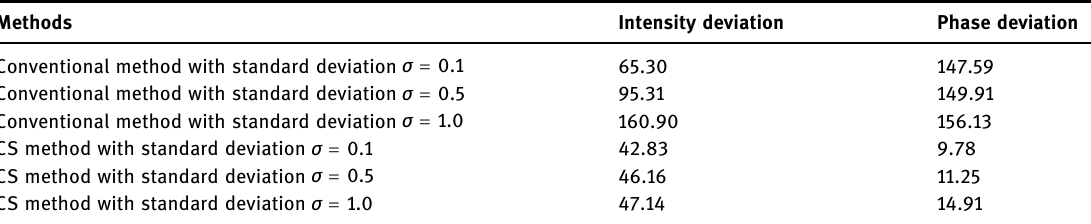
Table 1: MSE between original and reconstructed USAF resolution chart Methods Intensity deviation Phase deviation Conventional method with standard deviation = σ 0.1 Conventional method with standard deviation = σ 0.5 Conventional method with standard deviation = σ 1.0